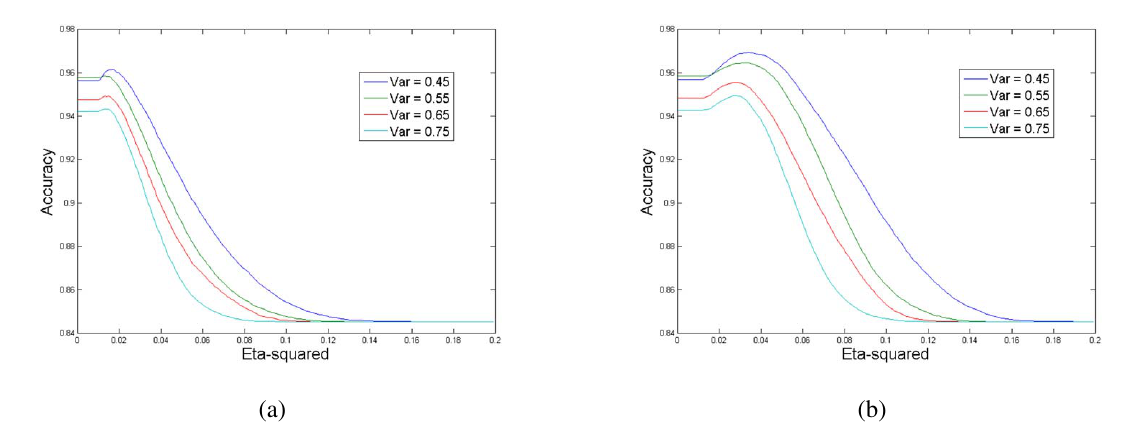
Figure 8. The accuracy variation as the η 2 parameter changes on the four images with different noise levels. ( a ) the ordinary ANOVA; ( b ) the modified